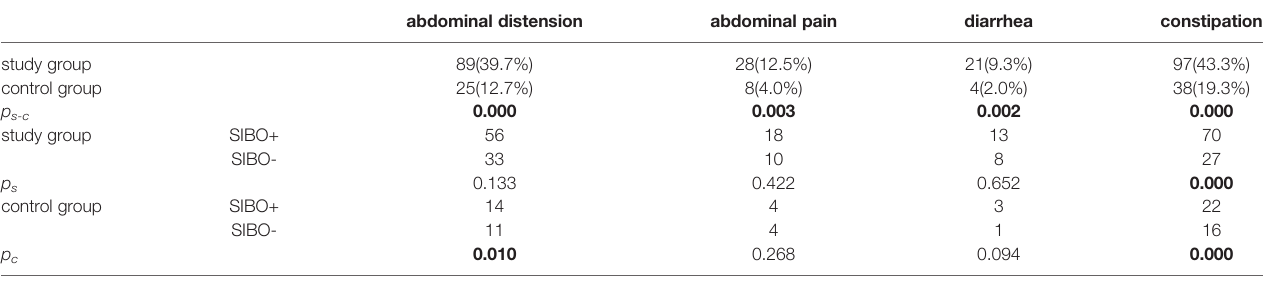
Boldface indicates statistical signi fi cance. p s-c : The p value of clinical abdominal symptoms between study group and control group. p s : The p value of clinical abdominal symptoms between patients with SIBO-positive and negative in study group. p c : The p value of clinical abdominal symptoms between patients with SIBO-positive and negative in control group.